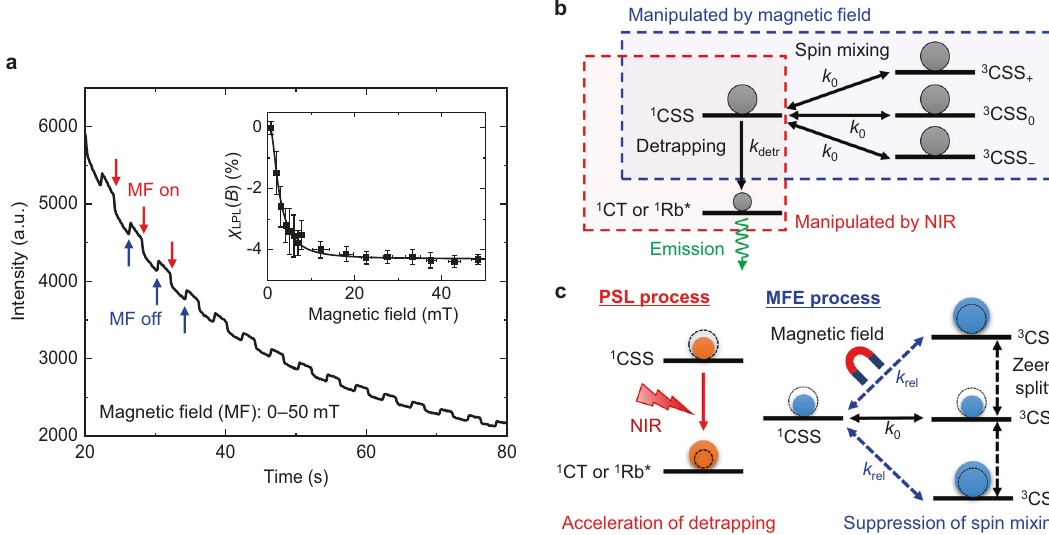
Fig. 4 Magnetic fi eld effects. a The response of LPL intensity to the external magnetic fi elds observed for the m-MTDATA/PPT/Rb fi lm. The inset shows the plots of χ LPL ( B ) as a function of the external magnetic fi eld ( B ). The solid line shows the least-squares fi t of data to the Lorentzian function. b A schematic illustration of spin mixing between singlet and triplet CSSs ( 1/3 CSSs) and detrapping. k detr = 10 − 2 – 10 0 s − 1 . k 0 ≈ 10 8 s − 1 . c A proposed model for NIR and magnetic fi eld-induced population changes (circles in dotted lines) of luminescent species and 1/3 CSSs. k rel = 10 3 – 10 6 s − 1